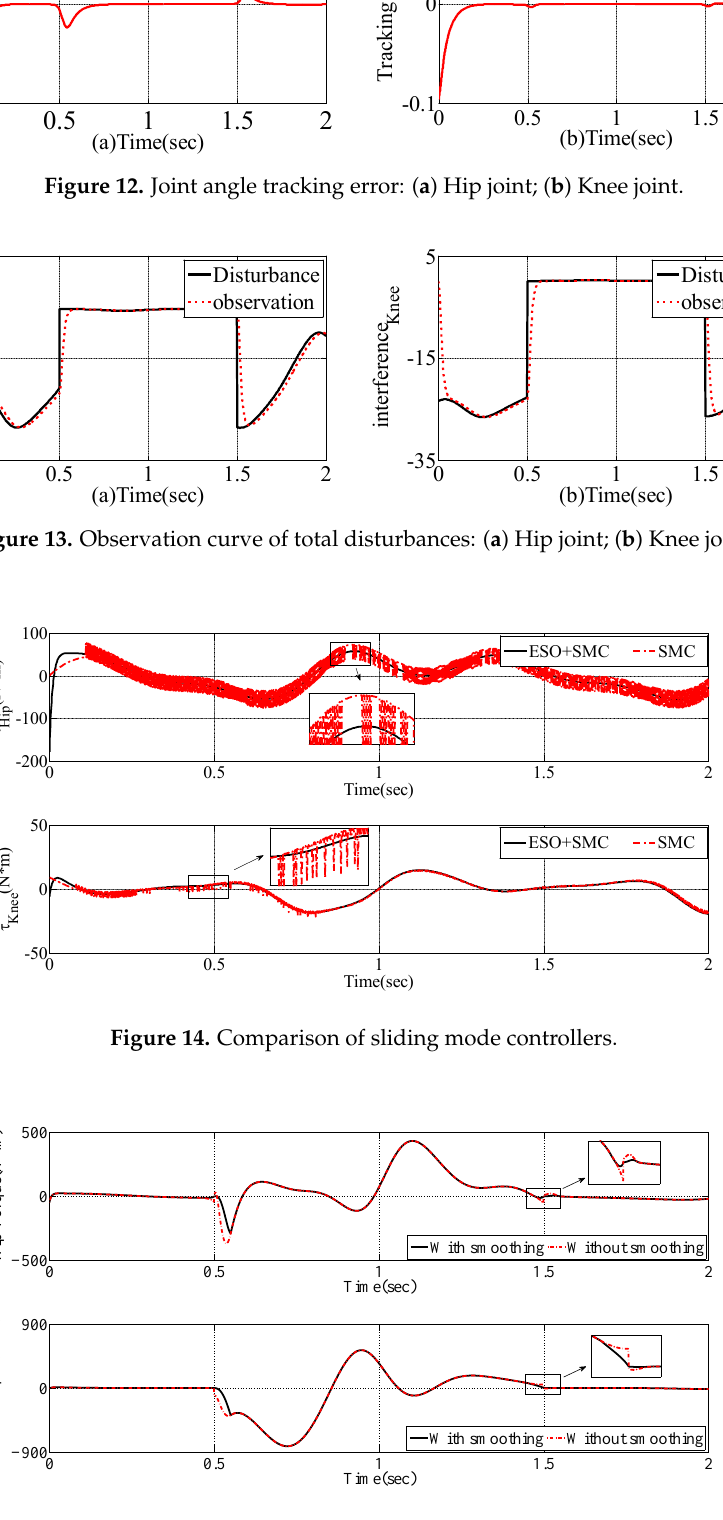
Figure 15. Smoothing control input